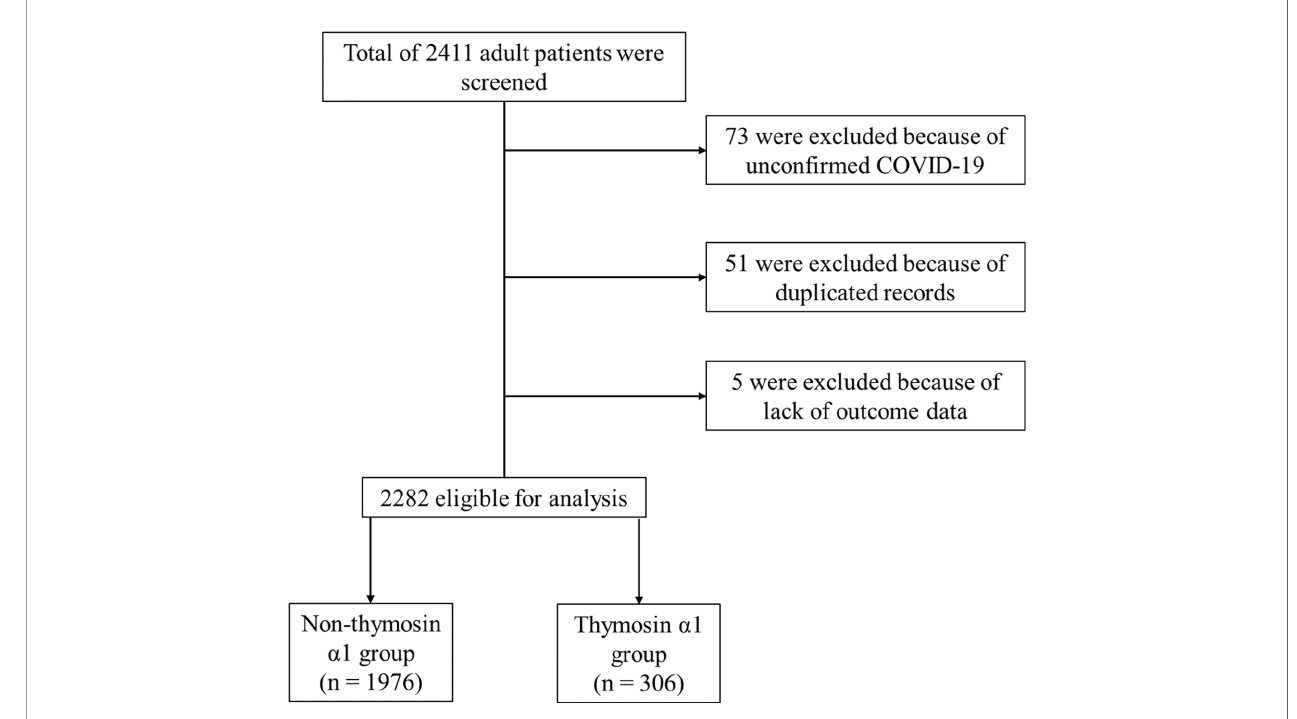
FIGURE 1 | Flow chart of the present